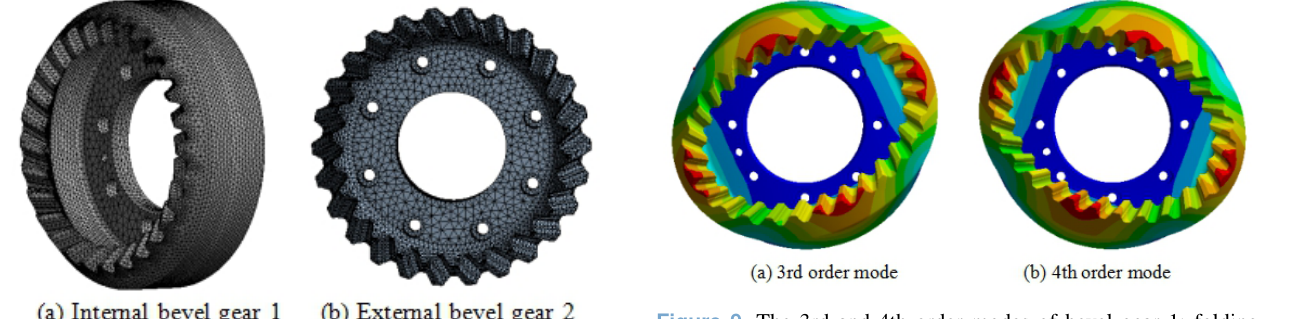
Figure 9. The 3rd and 4th order modes of bevel gear 1: folding vibration.